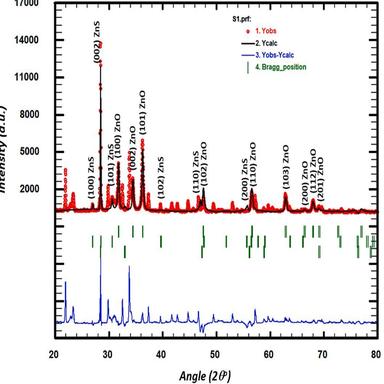
The Rietveld refinement of XRD spectra of the annealed sample.